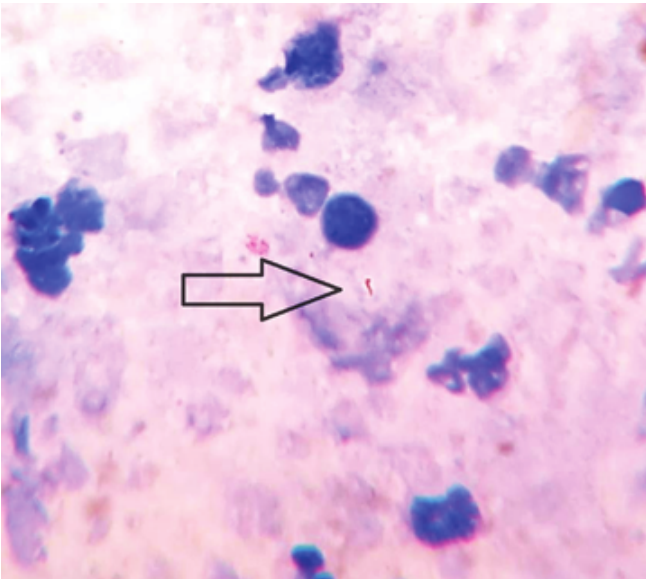
Figure 4 : Photomicrograph showing acid fast bacilli; oil-immersion 1000x (Ziehl-Neelsen stain).